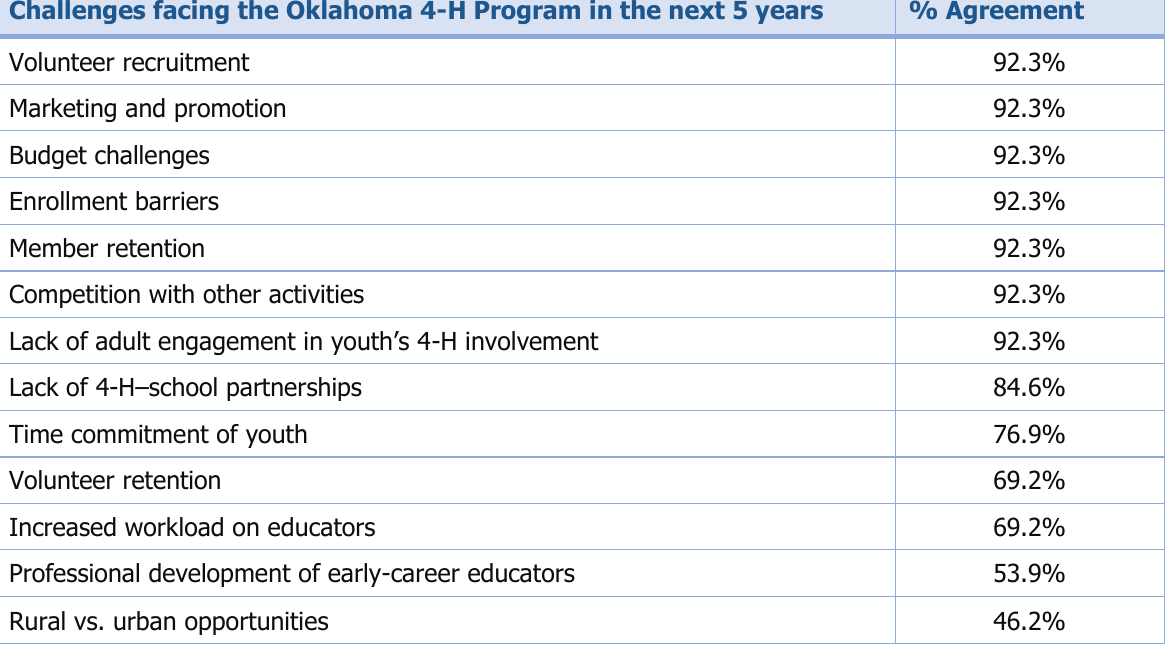
Table 1. Challenge Statements and Agreement Percentages in Round 2: Panel